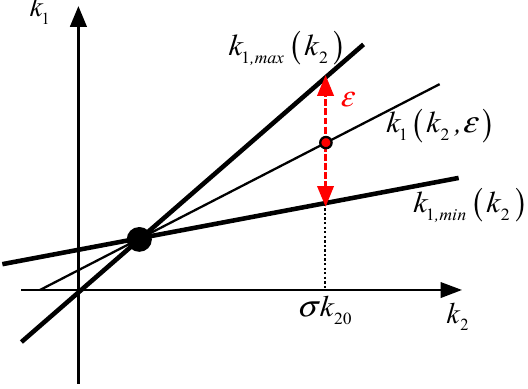
Figure 2. Regulation of k 1 and k 2 coefficients inside the cone.